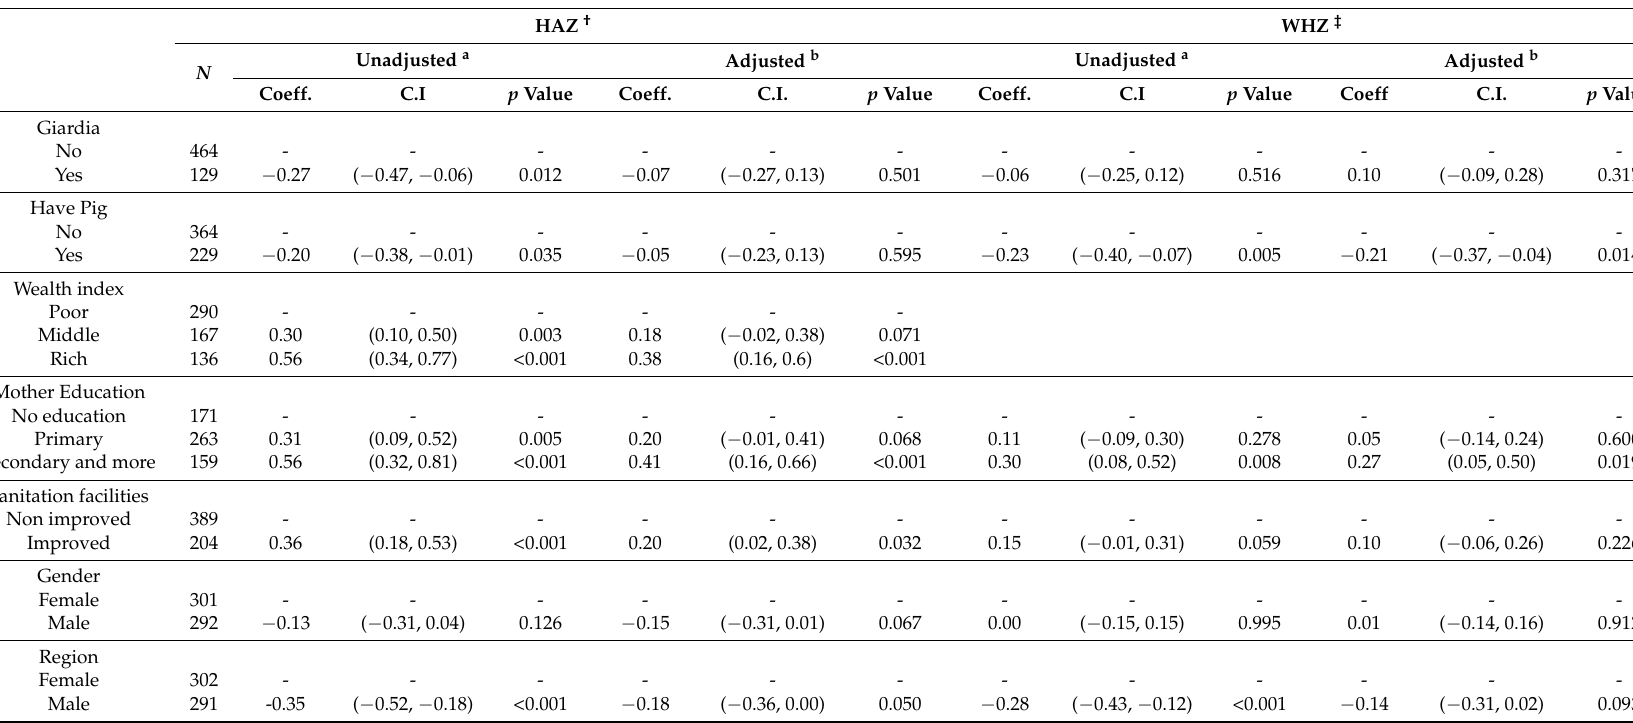
Table 4. Linear regression models explaining the associations between anthropometric z-score and selected